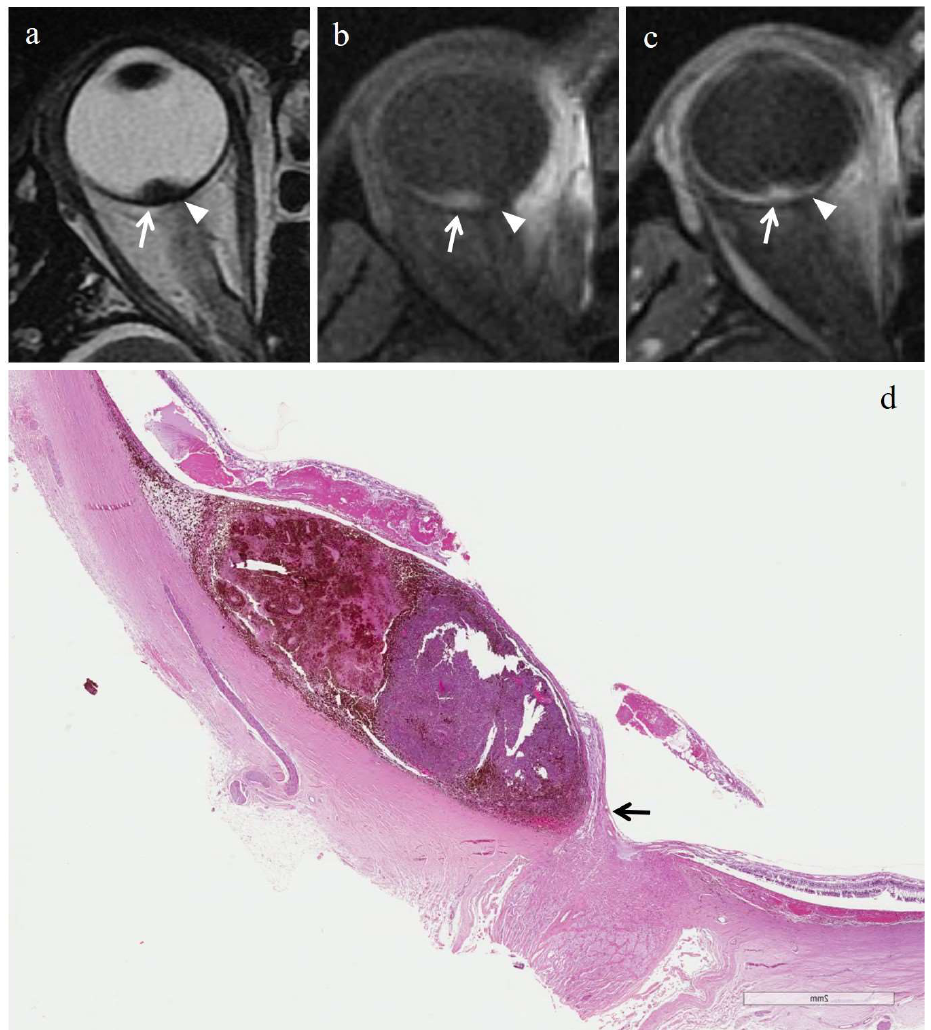
Figure 3. Radiation-induced necrosis. A 54-year-old male patient with a choroidal melanoma of the right eye. The patient underwent secondary enucleation 36 months after proton beam radiotherapy because of tumor regrowth. Axial ( a ) T2-weighted turbo spin-echo and ( b ) fat-suppressed T1- weighted mages demonstrate a lentiform-shaped intraocular lesion along the posterior aspect of the globe, adjacent to the optic nerve head. Two distinct portions are recognizable within the lesion. A lateral area (white arrows), hypointense on T2-weighted and hyperintense on T1-weighted images, representing radiotherapy-related necrosis; a medial portion (white arrowheads) with intermediate signal intensity, indicative of viable neoplastic tissue related to tumor recurrence of a poorly pigmented melanoma. On ( c ) axial contrast-enhanced fat-suppressed T1-weighted image the viable neoplastic tissue enhances (white arrowhead) and the distinction between the two portion of the lesion is hardly recognizable because of the intrinsic hyperintensity of radiotherapy-related necrosis (white arrow). ( d ) Histological low magnification (H&E, original magnification 50×) showing the conventional pattern of radiation-induced necrosis in uveal melanoma. A sharp demarcation between the residual poorly pigmented, viable tumor mass (on the right) and the abundant and heavily pigmented necrotic tissue (on the left) is seen. Note the emergence of the optic nerve (black arrow), compressed but not infiltrated by the tumor.